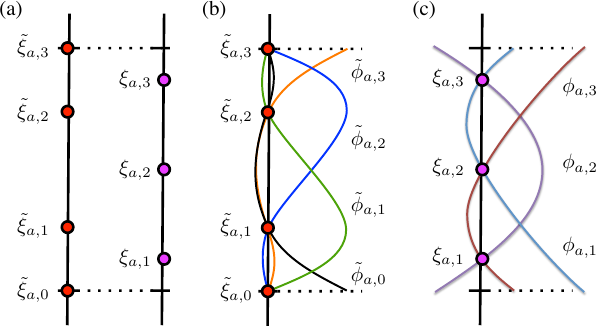
Figure 1. (a) Vertical placement of (left) Gauss–Lobatto nodes and (right) Gauss nodes within a vertical element with n vp = 3. (b) Basis functions e φ a,k for Gauss–Lobatto nodes within element a . (c) Basis functions φ a,k for Gauss nodes within element a .